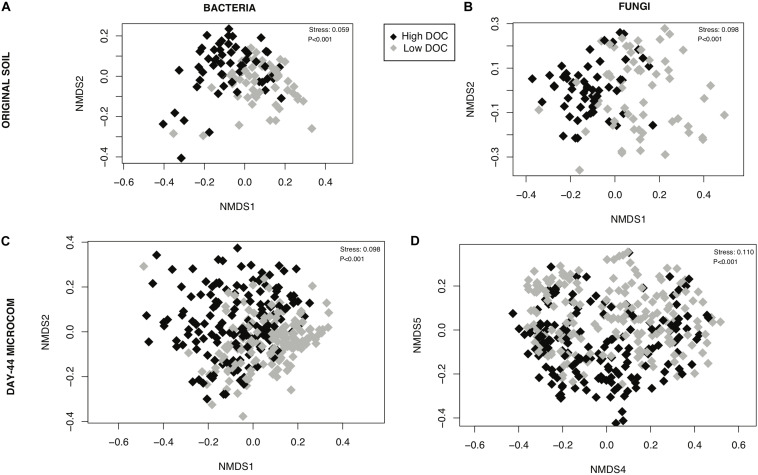
Relationship between microbial community composition and dissolved organic carbon (DOC) concentration. Non-metric multidimensional scaling ordinations performed on rarefied data for (A) bacterial communities in original soils, (B) fungal communities is original soils, (C) bacterial communities in day-44 microcosms (D) fungal communities in day-44 microcosms. Points are shaded by DOC cohorts: high (black) and low (gray). The stress value is derived from six dimensions.